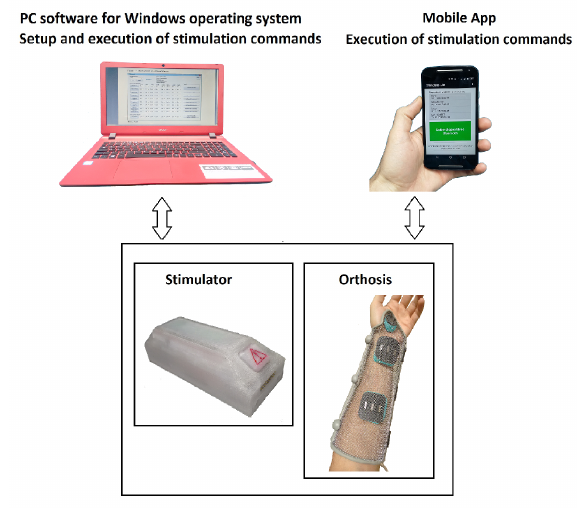
Figure 2. Main elements of the